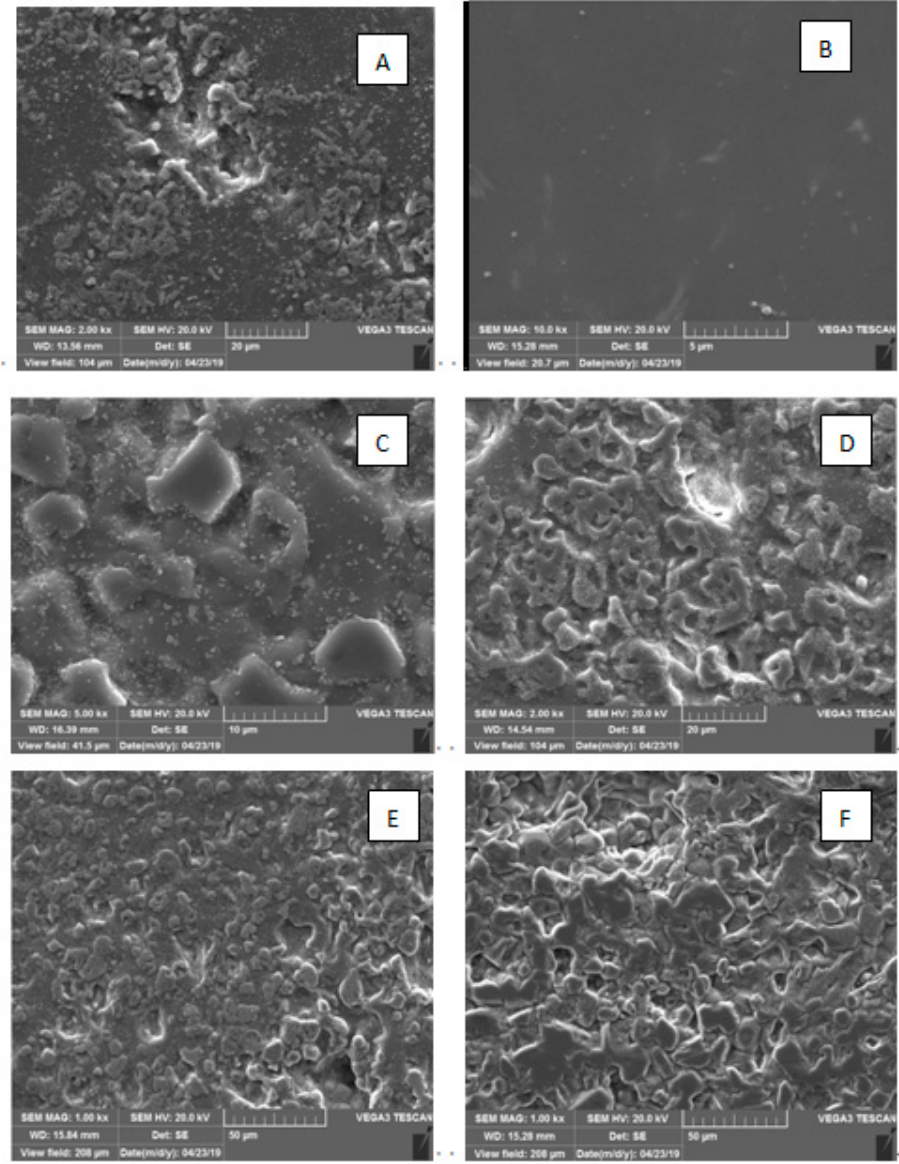
Figure 3. Microstructure of di ff erent kinds of calcined bauxite.The surface of type ( A ) and type ( B ) relatively smooth, while the surface of type ( C – F ) is relatively